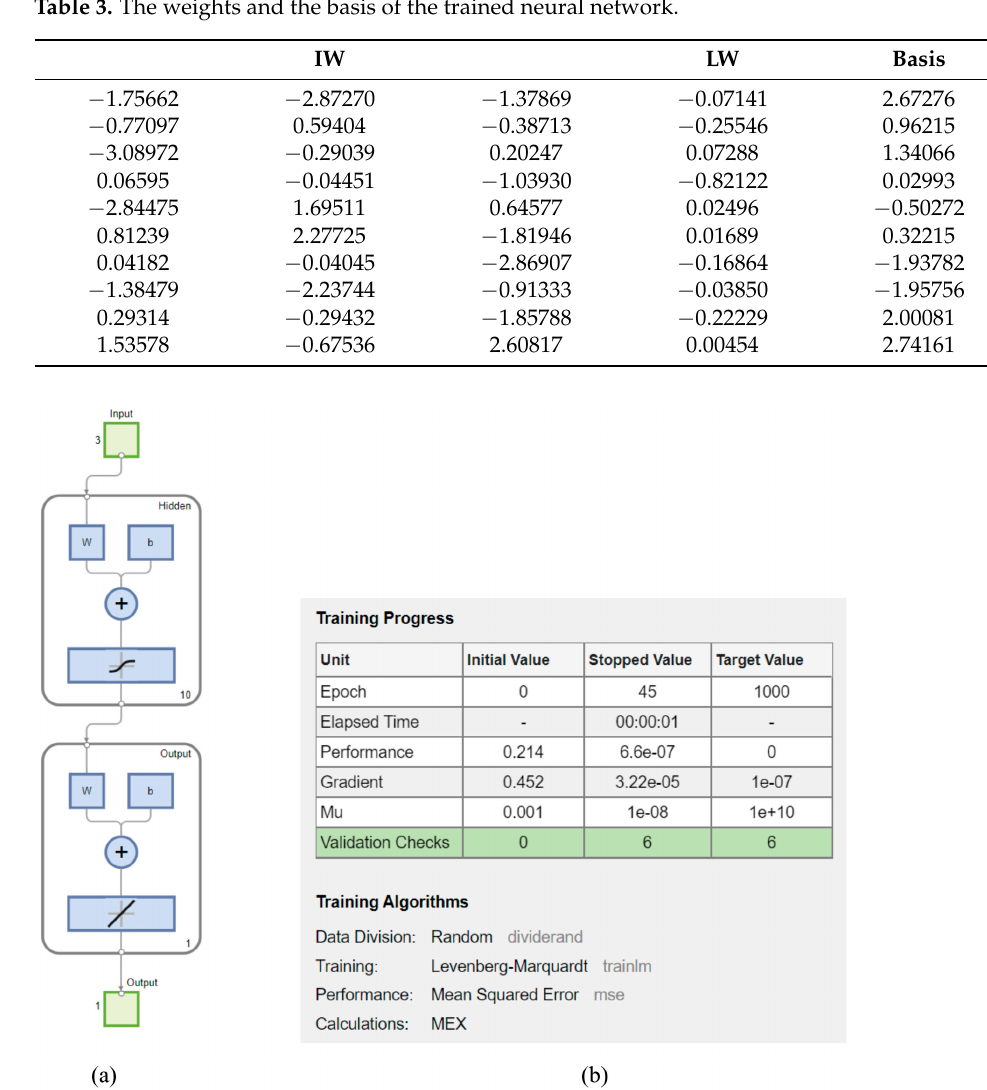
Figure 12. The structure of the utilized ANN and the applied settings. ( a ) the structure of the ANN with a hidden layer and input and output layer. ( b ) the training parameters and convergence crite- ria.